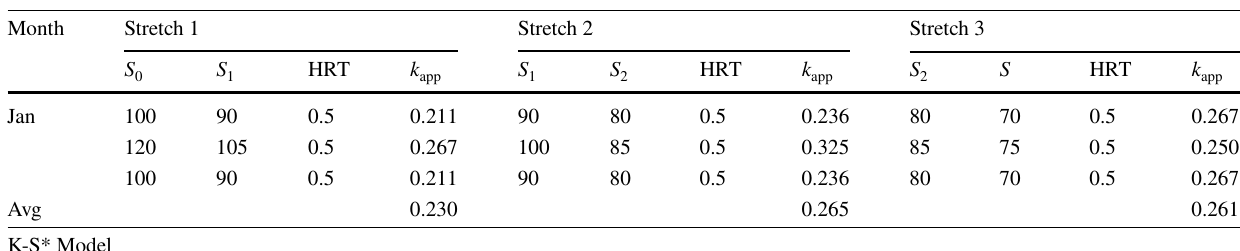
Table 4 Typical computations of k Plug flow model